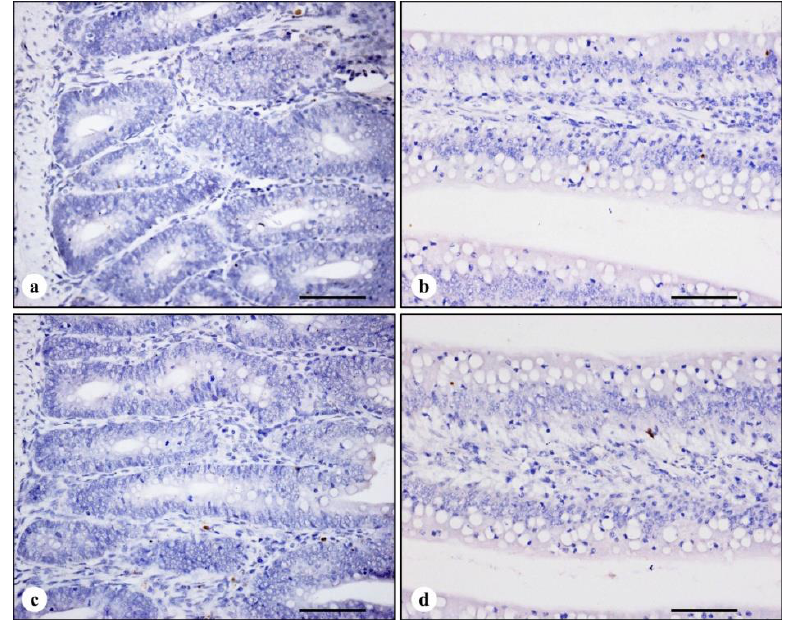
Figure 2. TUNEL immunohistochemistry staining in the crypts and in the middle regions of jejunal villi at 14 days of age. There are a few scattered TUNEL-positive cells in the crypts and in the middle regions of villi in all treatments. ( a ) The crypts in control broiler; ( b ) the middle regions of villi in control broiler; ( c ) the crypts in AFB 1 broiler; ( d ) the middle regions of villi in AFB 1 broiler. Bars = 50